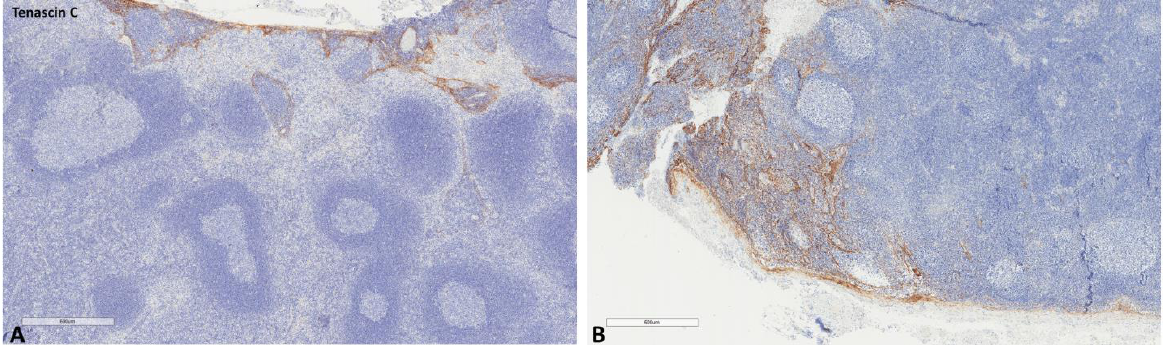
Figure 5. Representative microscopic images of PD-L1 expression (higher magnification) in a normal cancer-draining lymph node ( A ) and a normal non-cancer-draining lymph node ( B ).